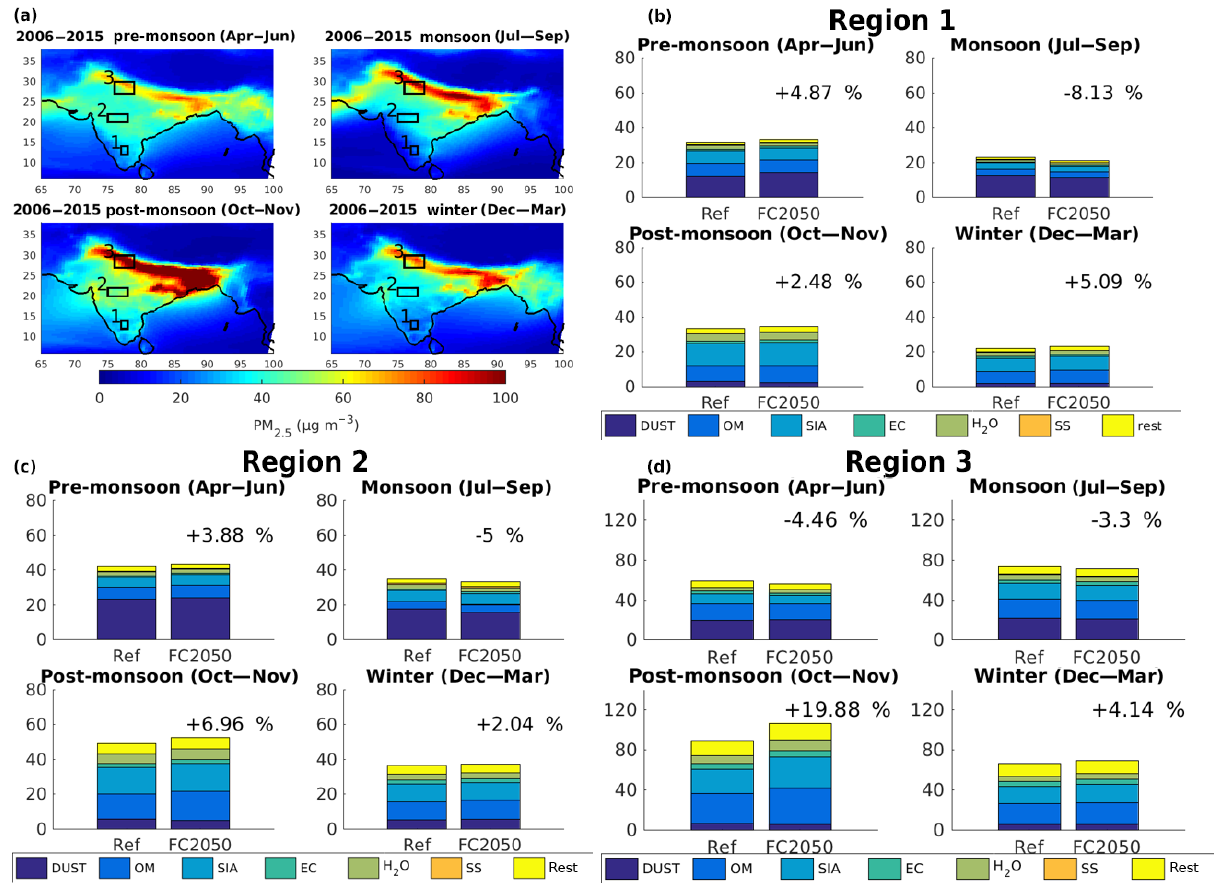
Figure 10. Seasonal distribution of surface PM 2 . 5 concentrations (in µgm − 3 ) for the reference scenario, and seasonal composition of PM 2 . 5 (in µgm − 3 ) for the three regions highlighted by black boxes on the map for the reference and the FC2050 scenarios. The black percent corresponds to the relative difference in PM 2 . 5 between both scenarios for each region. Note the different y axis for Region